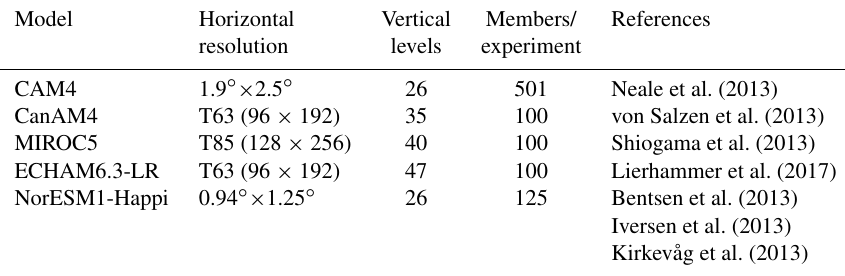
Table 1. Models used in the study, including the number of ensemble members run for each of the PD and 1.5 and 2.0 ◦ C experiments.